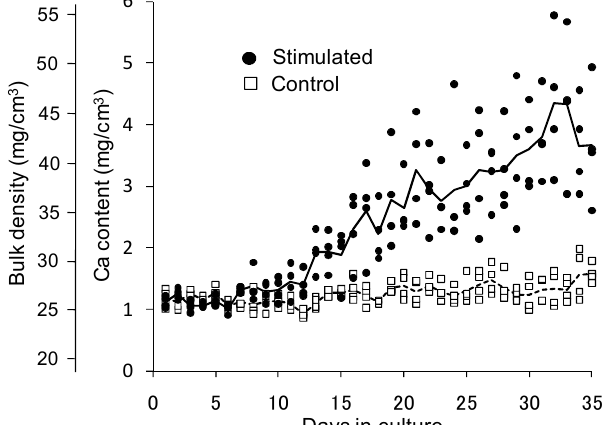
Figure 3 Change in the Ca content and the bulk density of constructs over time in culture. The solid and dash lines represent the averages of the stimulated group and the control group, respectively.